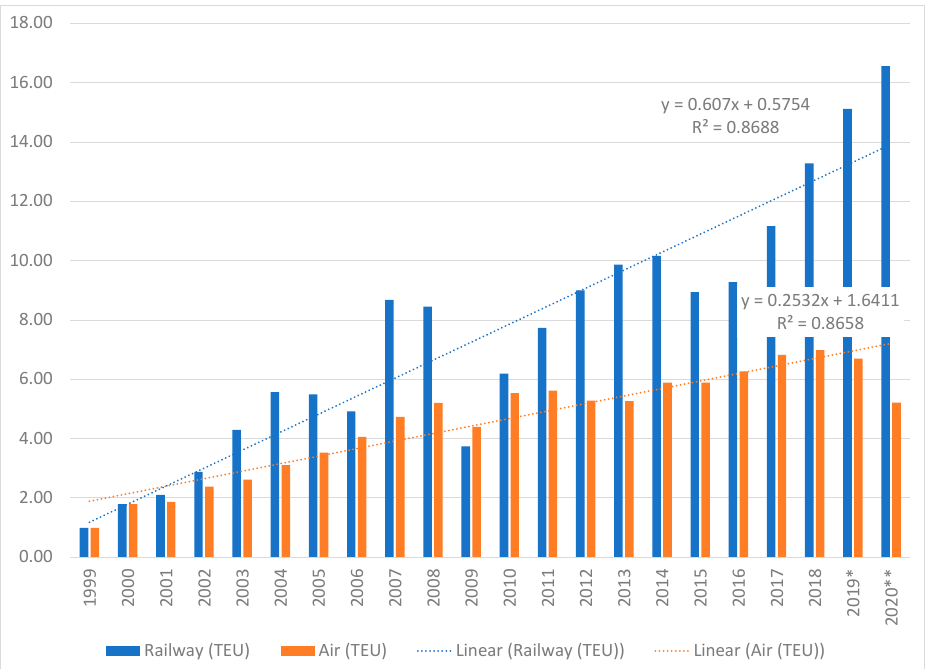
Figure 3. Container transportation volume development between Asia and Europe within transportation modes of rail and air (indexed, year 1999 = 1). Denotation: *, railway container volumes estimated with data ending to August 2019; **, railway container volumes estimated within international transports with an average growth of 2009–2018; air freight estimated with first three quarters of 2020.